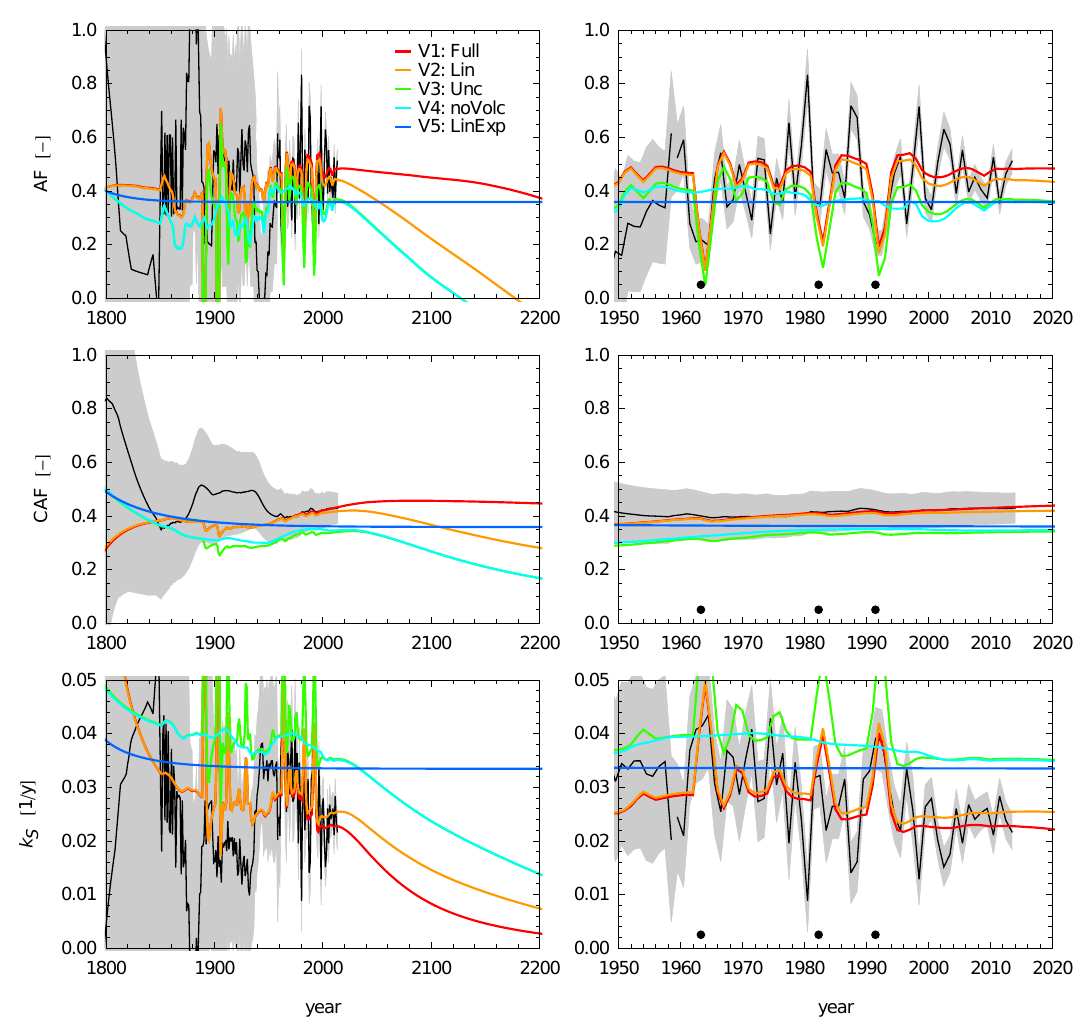
Figure 7. Trajectories of AF and k S (upper and lower rows) for the model simplification cases shown in Figs. 3 and 6. Dots in right (zoom) panels indicate times of major volcanic eruptions since 1959 (Agung, El Chichon, Pinatubo). Other details as in Figs. 4 and 5. This figure is a variation with added detail of Fig. 9 in Raupach (2013), using orderings for model simplification steps consistent with this